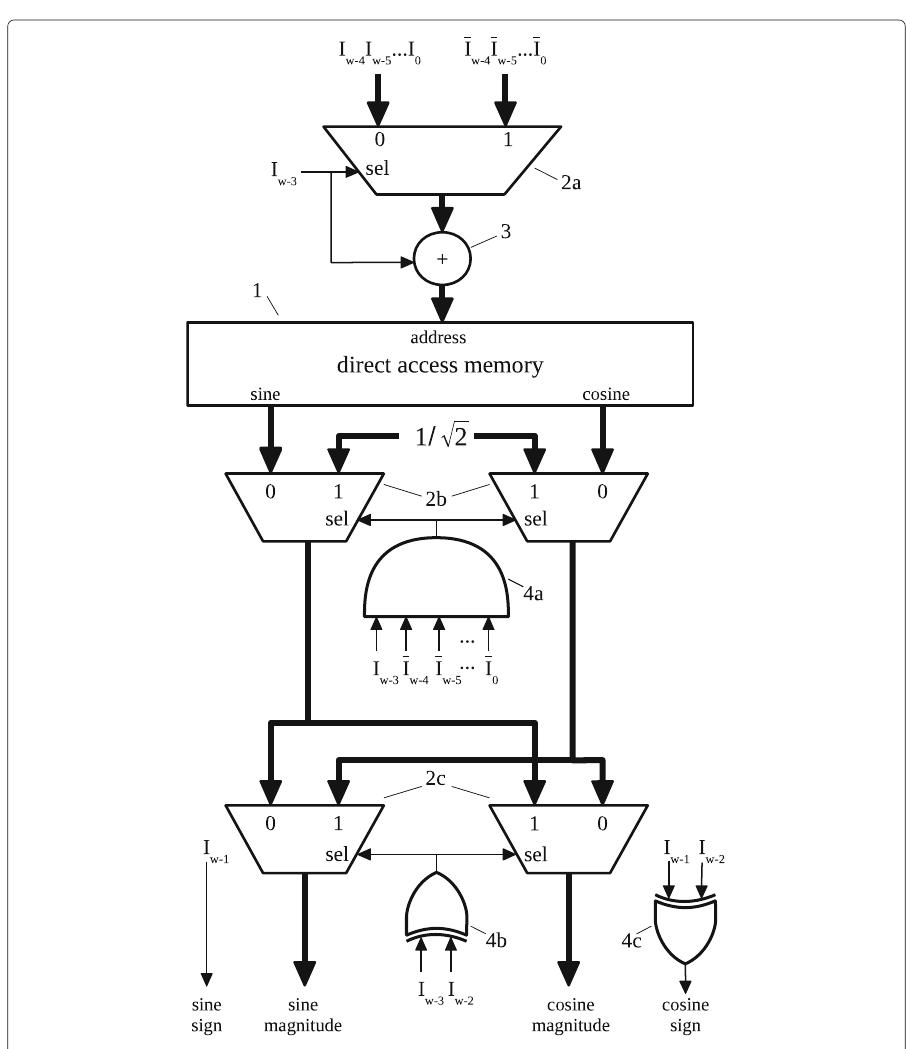
Fig. 1 Argument reduction employed to optimize a sine/cosine generator √ π/ 4, that is, 1 / 2, using a pair of multiplexers (2b) . The address lines of the memory are fed with the w − 3 least significant bits of I or with its two’s complement depending on I w − 3 , using the adder (3) and the multiplexer (2a) . The gate (4b) is employed to ascer- tain whether the magnitude of the sine and the cosine should be interchanged with the multiplexers (2c)